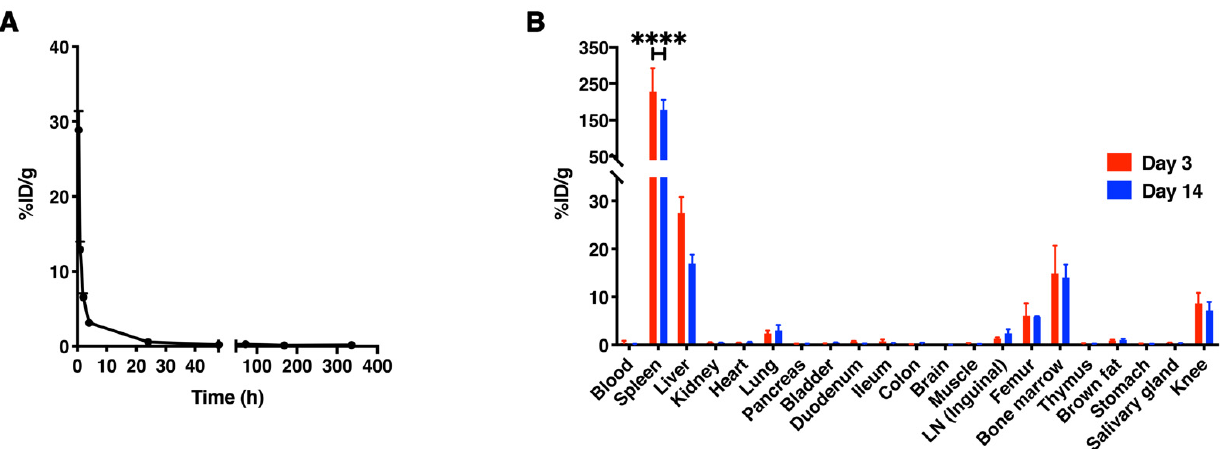
Figure 2. Blood clearance and biodistribution of [ 89 Zr]Zr-PLGA-NH 2 NPs. ( A ) [ 89 Zr]Zr-PLGA-NH 2 NPs clearance from blood after intravenously injection in C57BL/6 mice, measured at 0.5, 1, 2, 4, 6, 24, 48, 72, 168 and 336 h ( n = 3–6). ( B ) Organ accumulation of the [ 89 Zr]Zr-PLGA-NH 2 NPs at day 3 and day 14 post-injection ( n = 3 per group). Abbreviations: %ID/g, % injected dose per gram of organ; LN, lymph node. **** p < 0.0001.